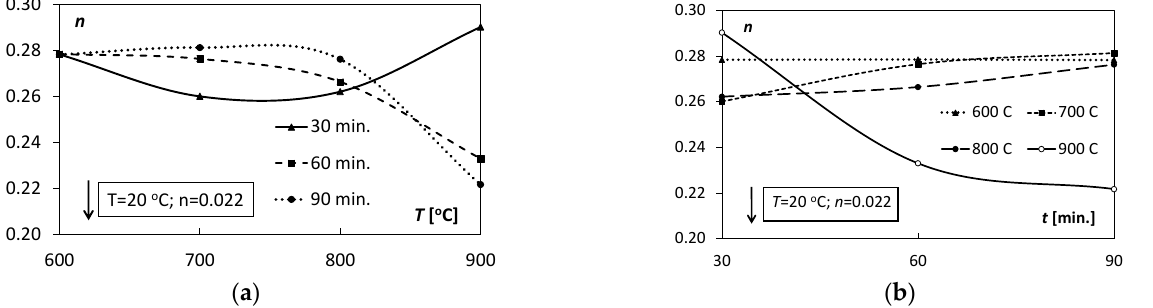
Figure 11. Dependence of the hardening coefficient n on: ( a ) annealing temperature T , ( b ) holding time t .